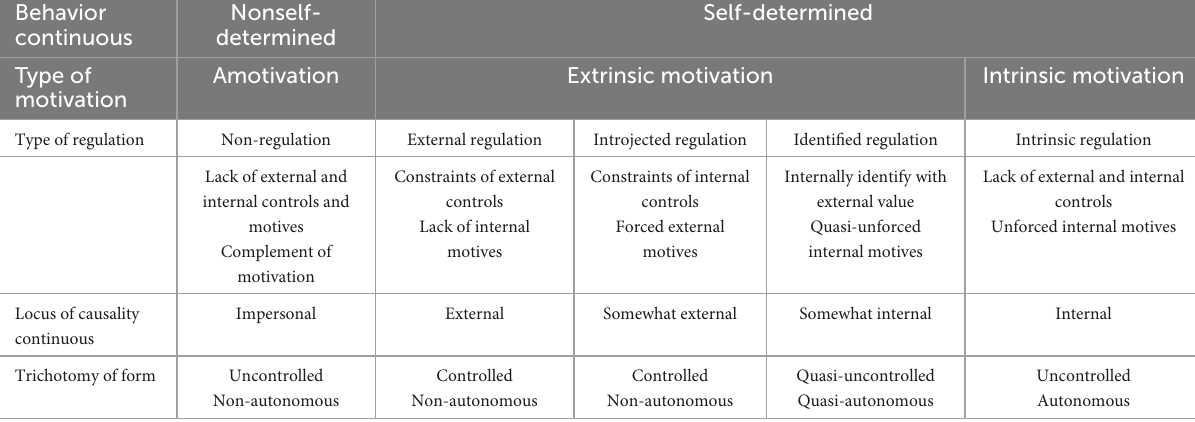
TABLE 1 Self-determination continuum also called SDT’s taxonomy of motivation (cf., Deci and Ryan, 2000). Behavior